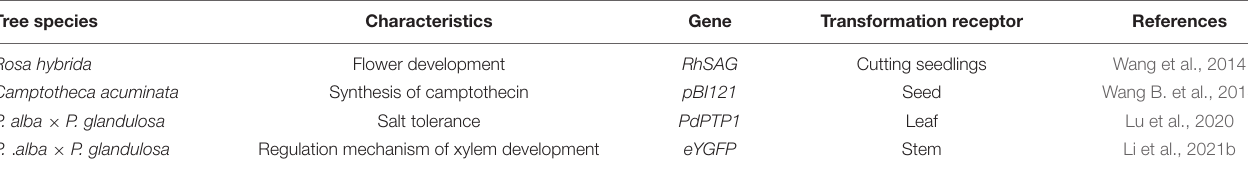
TABLE 6 | Application of instantaneous transformation in forest